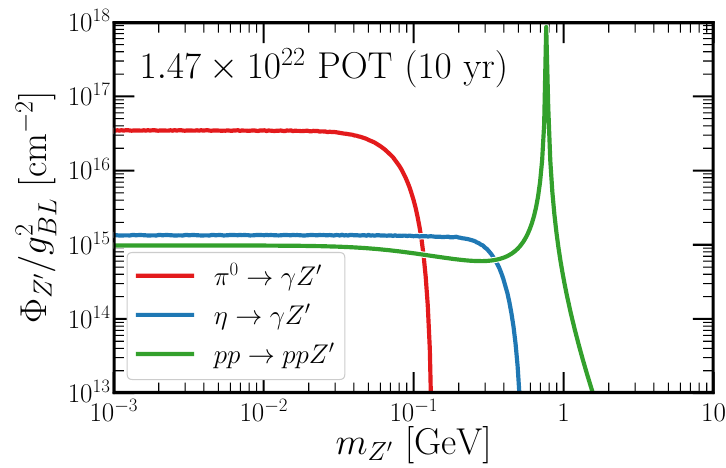
Figure 3 . Expected flux of Z 0 gauge bosons at the DUNE near detector in the channels of π 0 → γZ 0 , η → γZ 0 and pp → ppZ 0 , assuming the particles are all infinitely long-lived (and have not decayed en route). This flux scales with g 2 and has been determined assuming 1 . 47 × 10 22 protons striking BL the DUNE target, a conservative estimate for ten years of operation of the